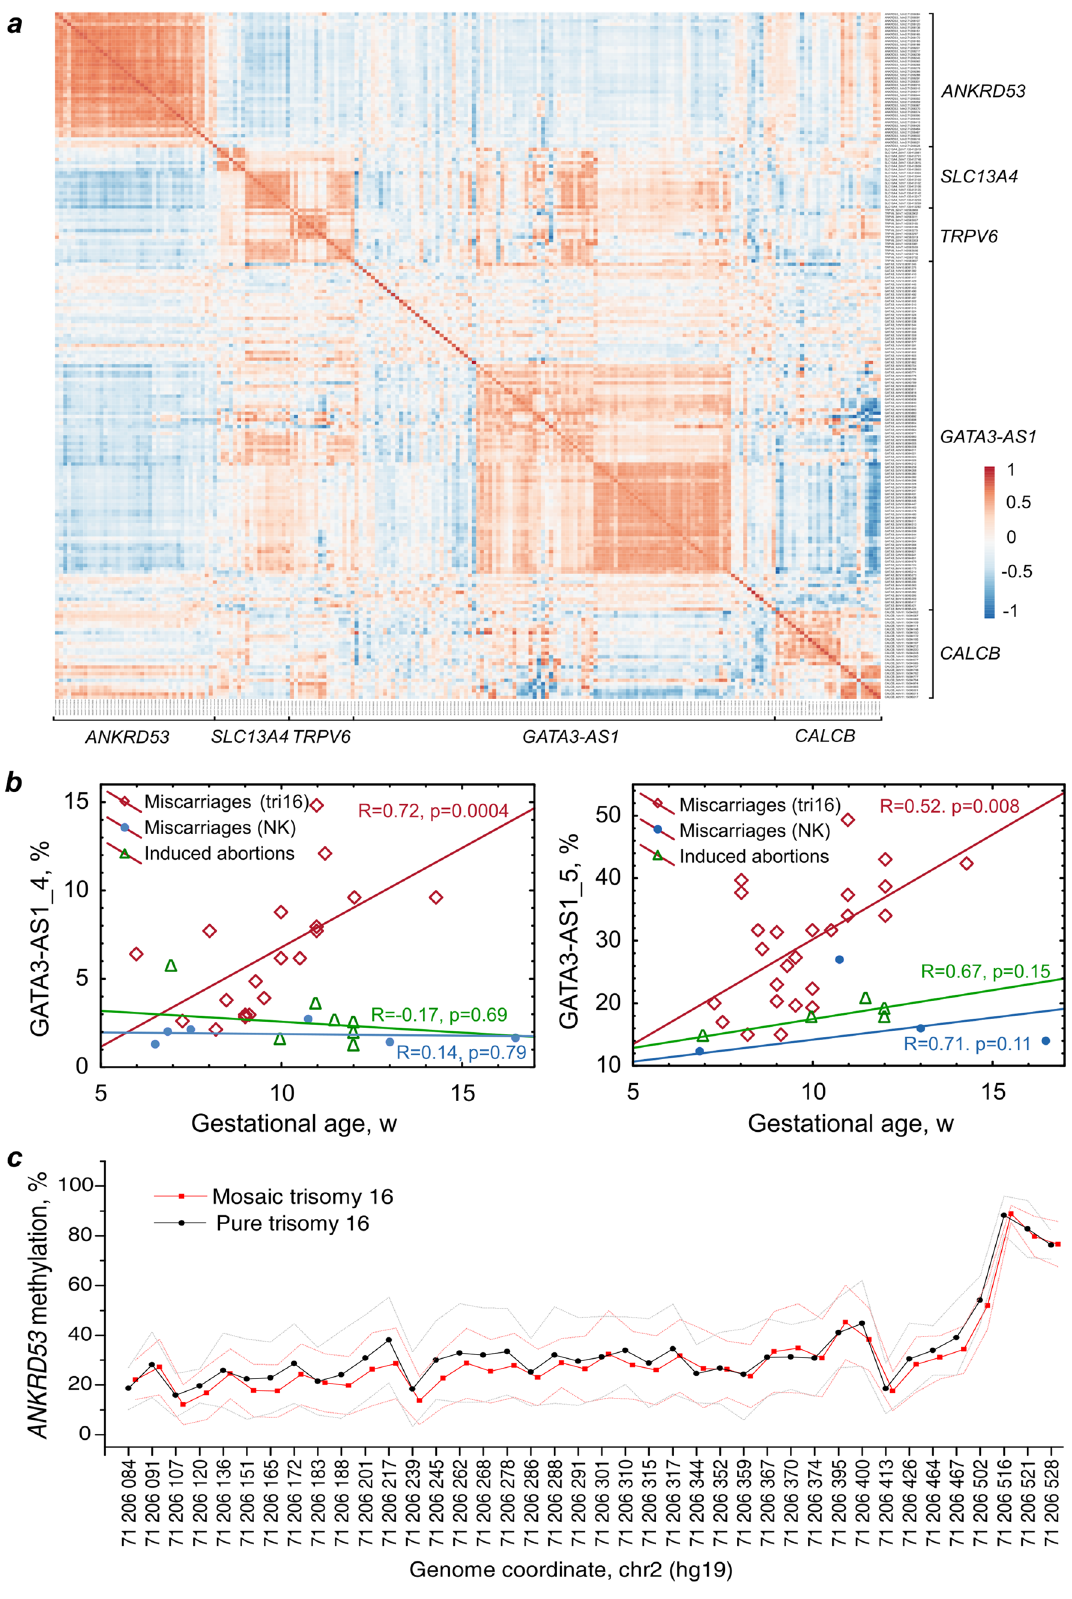
Figure 4. Correlation of the methylation indices of differentially methylated gene promoters with each other and their dependence on gestational age and chromosome mosaicism. ( a ) Correlation of the methylation indices of the ANKRD53, TRPV6, GATA3-AS1, SCL13A4, and CALCB genes with each other in chorionic villi of spontaneous abortions with trisomy 16. The heatmap was generated using the Spearman test and the ClustVis tool. ( b ) Correlation of the methylation indices of the GATA3-AS1_4-5 regions with the gestational age of miscarriages with trisomy 16, miscarriages with a normal karyotype, and induced abortions. ( c ) Comparison of the ANKRD53 gene methylation index in chorionic villi between groups of miscarriages with mosaic and pure trisomy